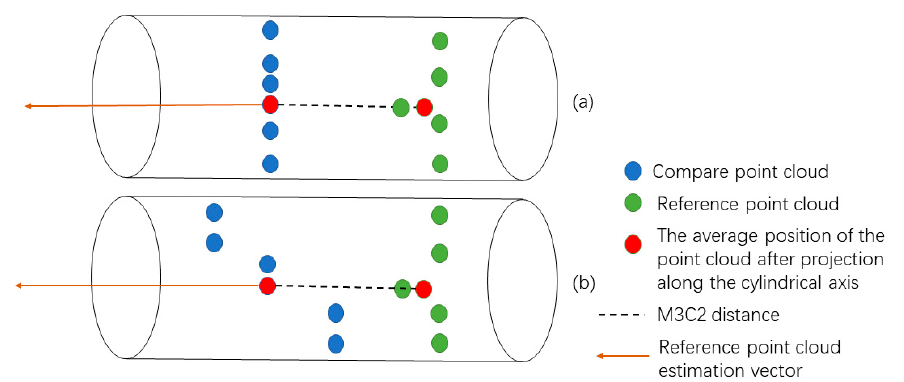
Figure 14. Comparison of M3C2 distance calculation effects of different point clouds. ( a ) M3C2 distance calculation results of low roughness compare point cloud. ( b ) M3C2 distance calculation results of high roughness compare point cloud.